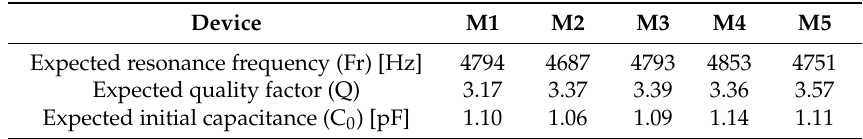
Figure 16. Cumulative distribution curves for resonance frequency, quality factor, and initial capacitance for the five different layouts (M1–M5).